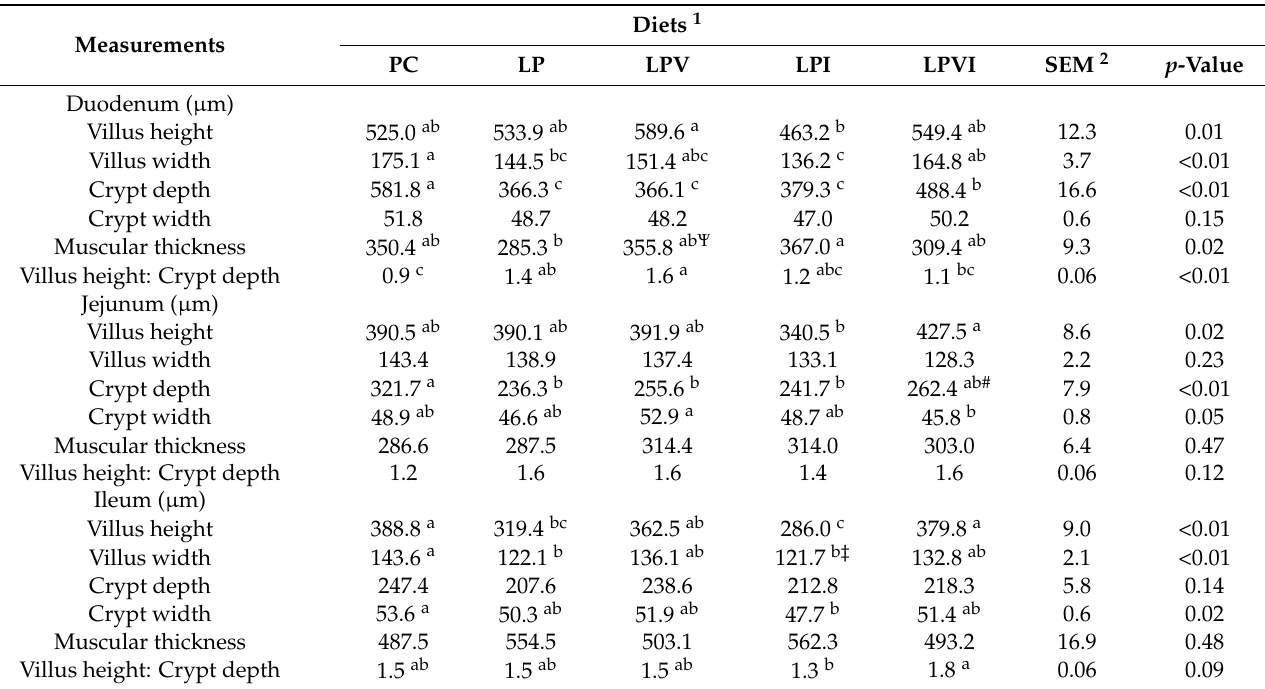
Table 2. Intestinal morphology of nursery pigs fed with very-low-protein diets supplemented with Ile, Val, or combination of